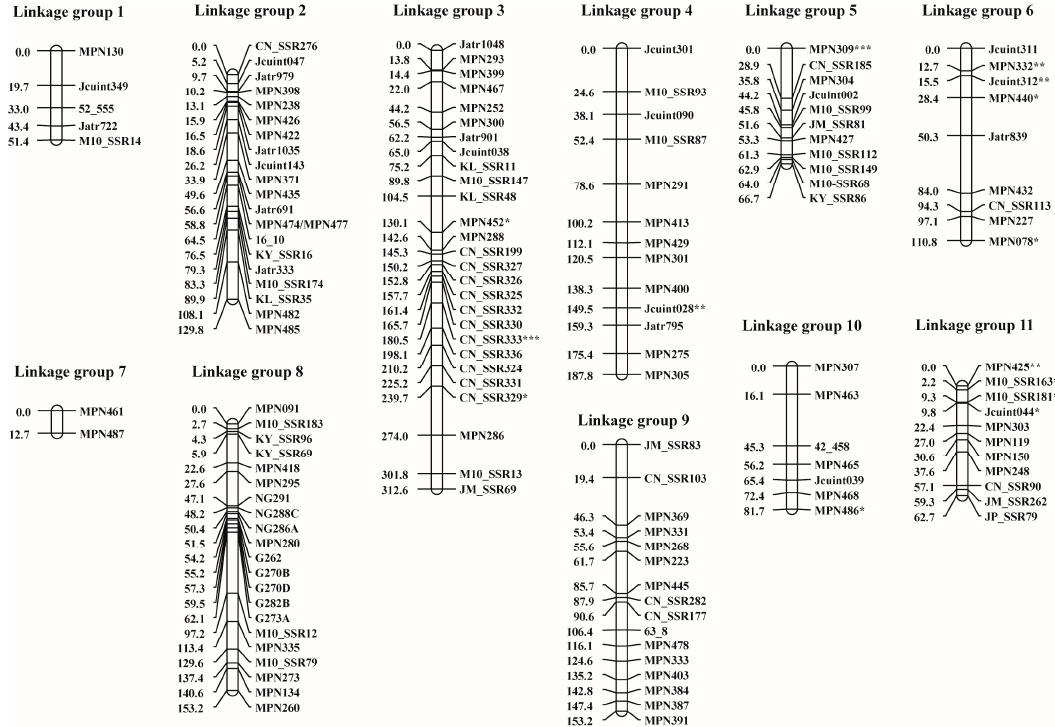
Figure 3. The genetic linkage map developed from 95 F 2 plants derived from the cross Chai Nat × M10 using 143 simple sequence repeat (SSR) markers. Genetic distance was shown in centimorgan unit. Linkage groups were named as per King et al. [6]. Markers showing significant deviation from the expected segregation ratio at 0.05, 0.01, and 0.001 probability levels are marked with *, **, and ***, respectively.